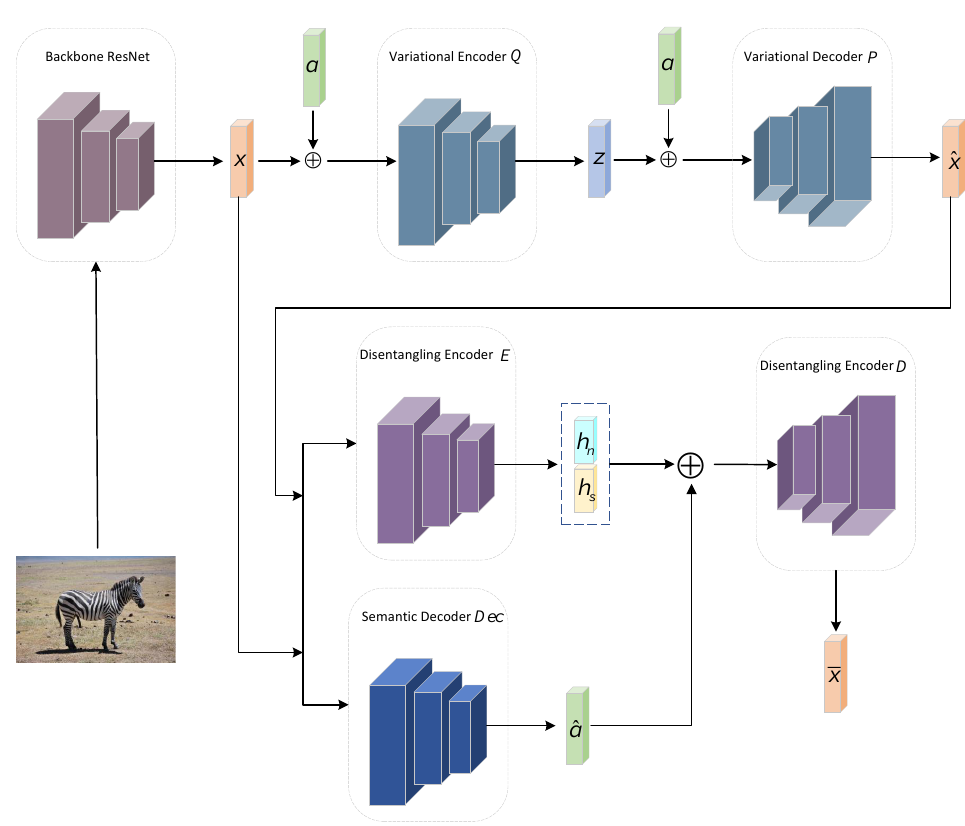
Figure 1. The proposed architecture for